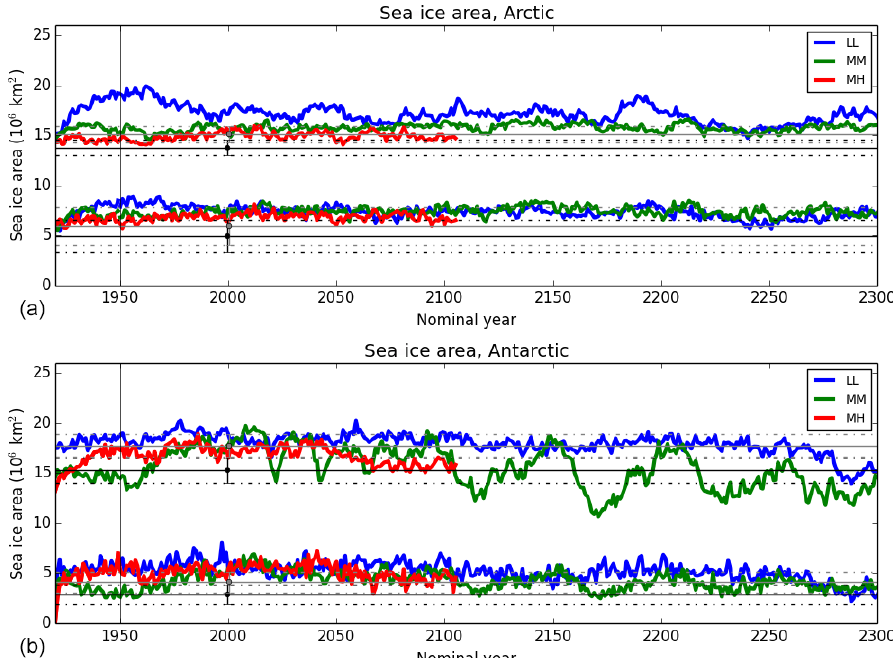
Figure 5. Time series of sea ice areas in the (a) Northern Hemisphere and (b) Southern Hemisphere for three model resolutions, for spinup- 1950 and control-1950 simulations. In each hemisphere, the winter and summer months (March, September in NH; September, March in SH) are shown by the upper and lower groups of contours, respectively. Observations are HadISST1.2 (black line) and HadISST.2.2 (gray line), with their mean value over 1990–2009, are shown as the solid line and the maximum and minimum during that period as dashed lines.